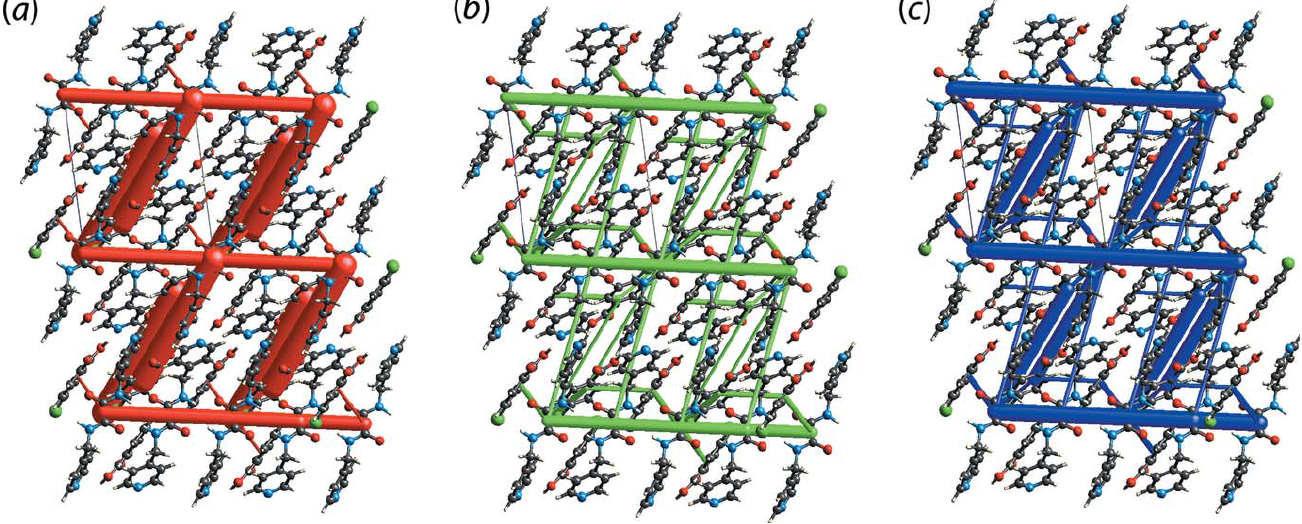
Figure 9 Perspective views of the energy frameworks of (I), showing the ( a ) electrostatic force, ( b ) dispersion force and ( c ) total energy. The radius of the cylinders is proportional to the relative strength of the corresponding energies and they were adjusted to the same scale factor of 100 with a cut-off value of 8 kJ mol (cid:4) 1 within a 2 (cid:7) 2 (cid:7) 2 unit